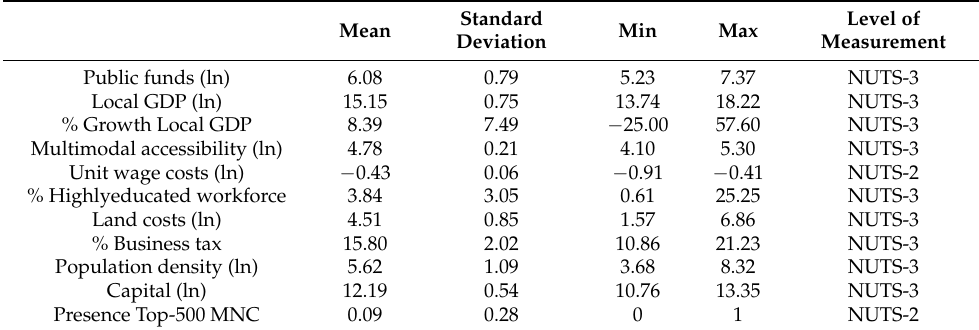
Table 3. Descriptive Statistics, Independent Variables (N =